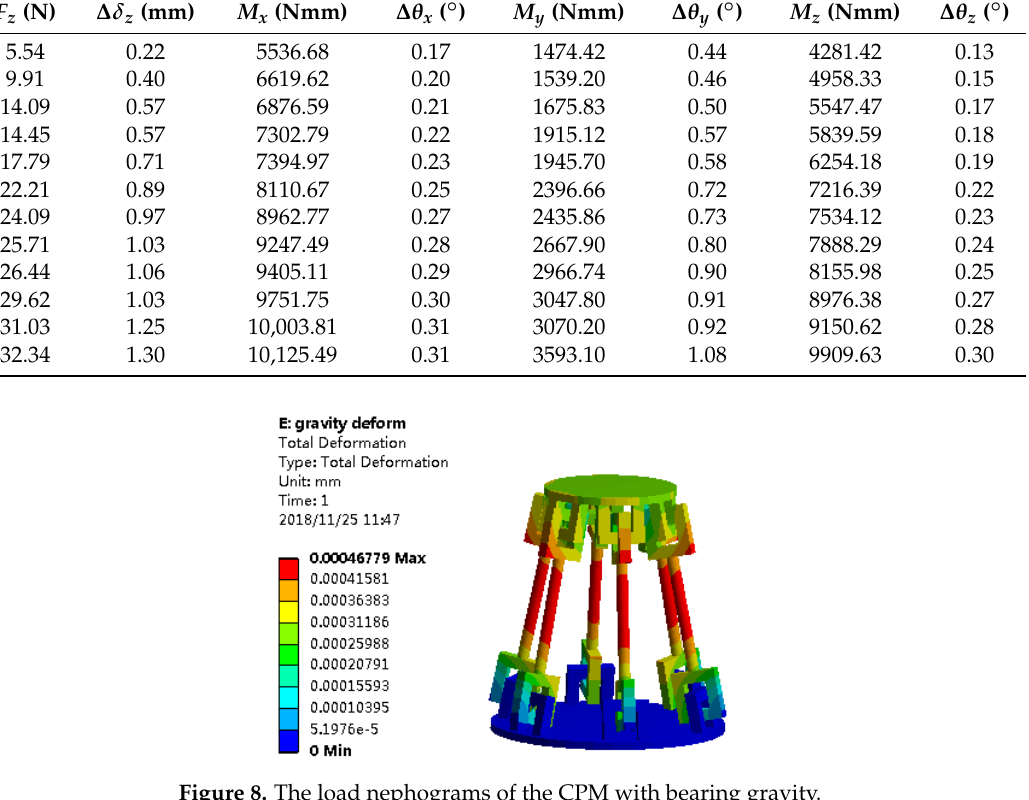
Table 2. Partial force/torque values corresponding to deformation values.